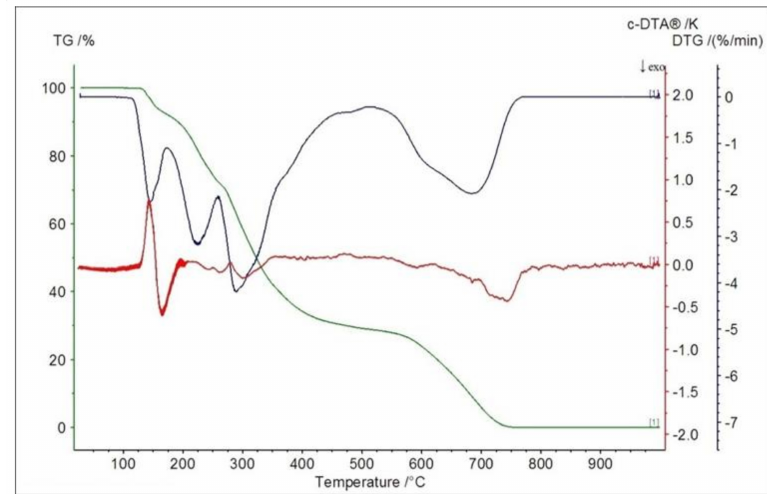
Figure 6. Thermal decomposition of compound 1 .